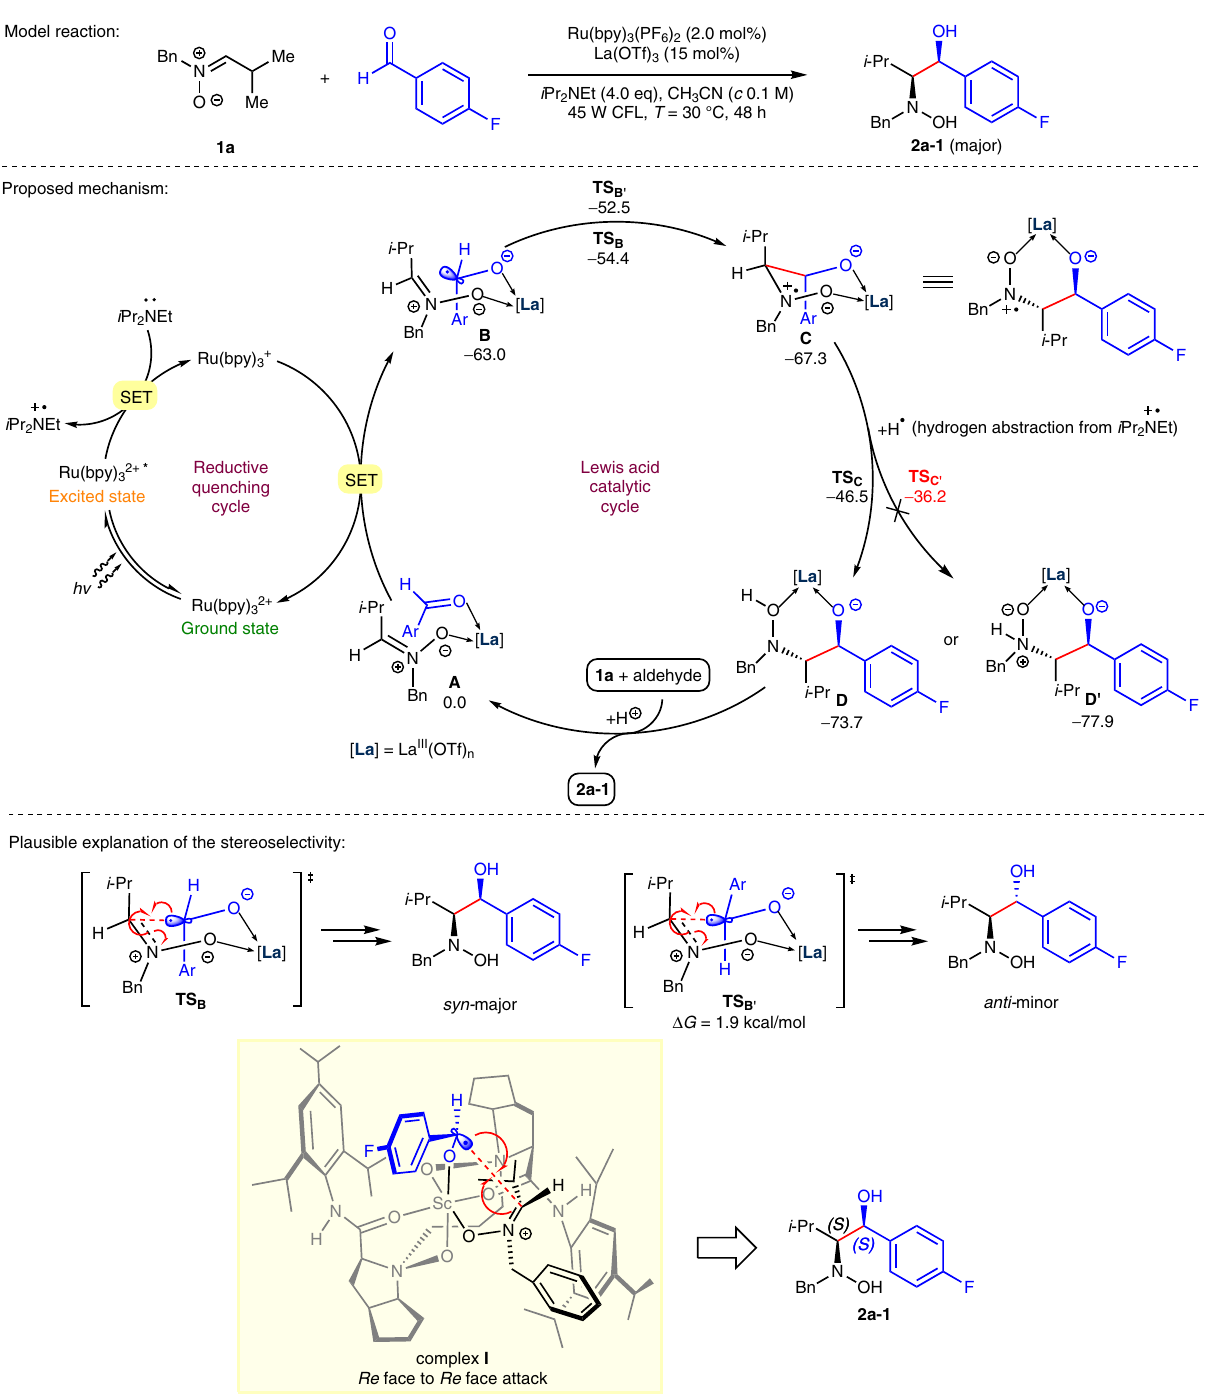
Fig. 3 Proposed mechanism of this photocatalytic enantioselective reductive cross-coupling reaction. Relative Gibbs free energies ( Δ G in kcal mol − 1 at 298 K) for key intermediates and transition states were computed at the SMD-B3LYP/DZP-level of